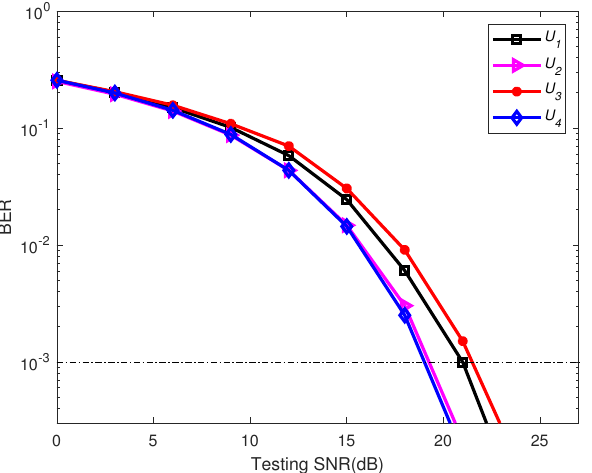
Figure 9. BER performance of the proposed scheme at different